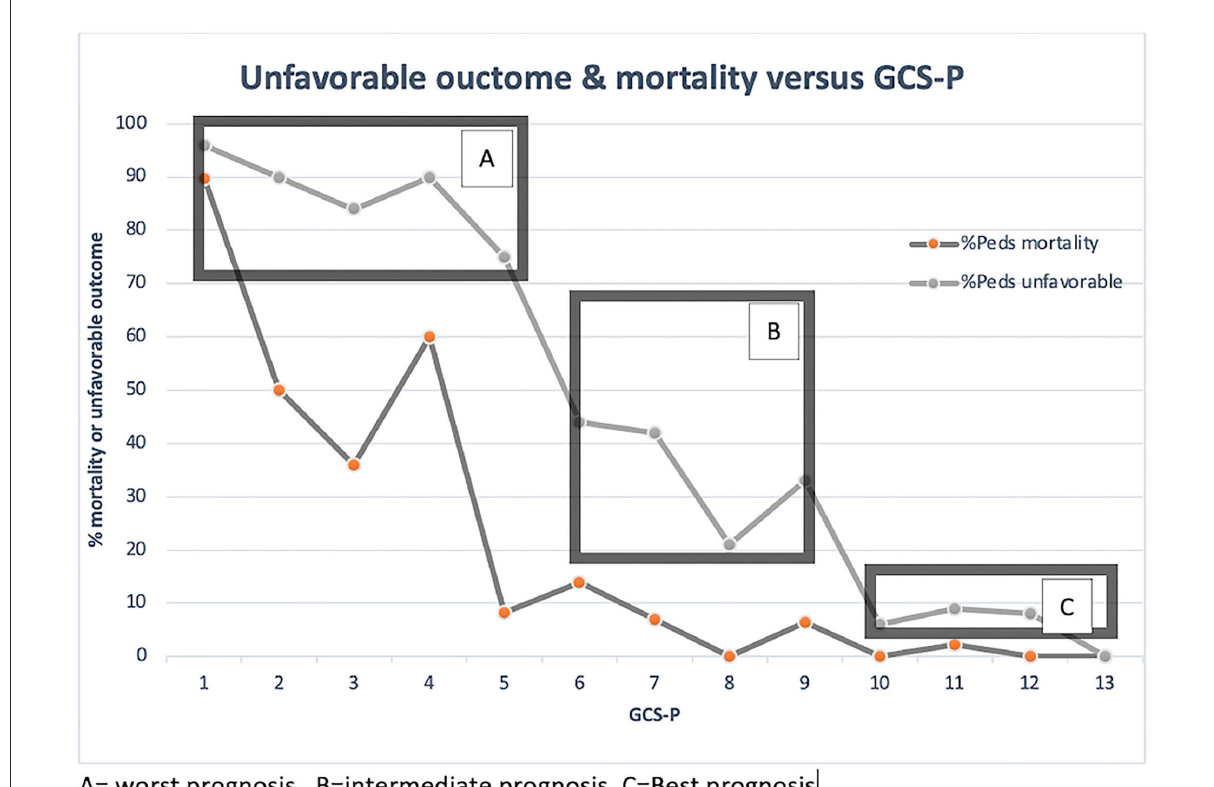
FIGURE2 GOS Dichotomized and Mortality vs.